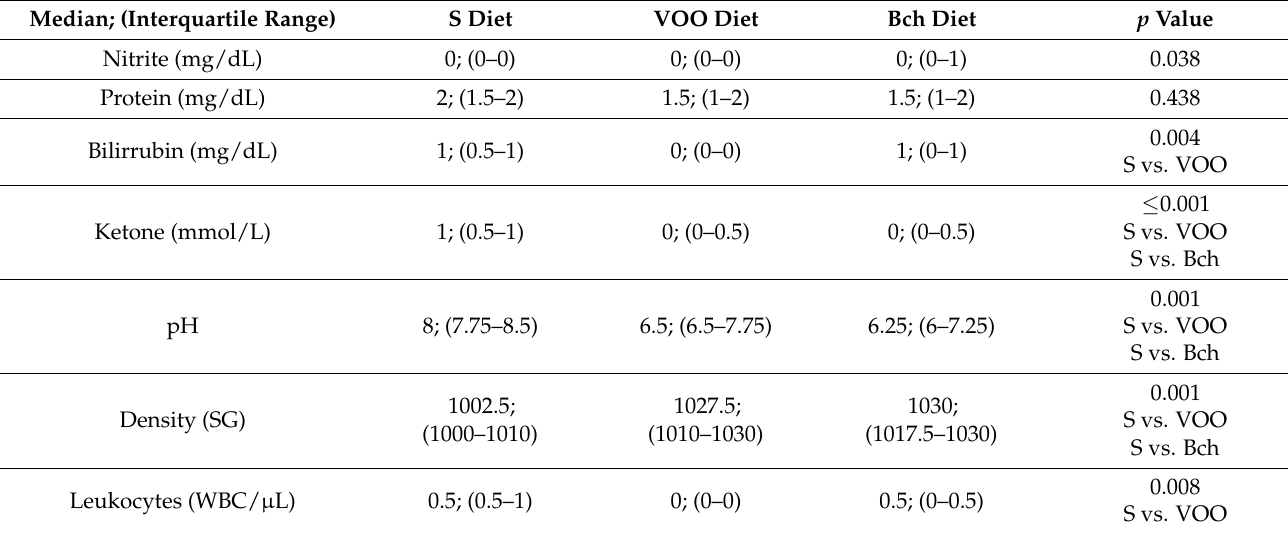
Table 1. Test range of urinary measurement